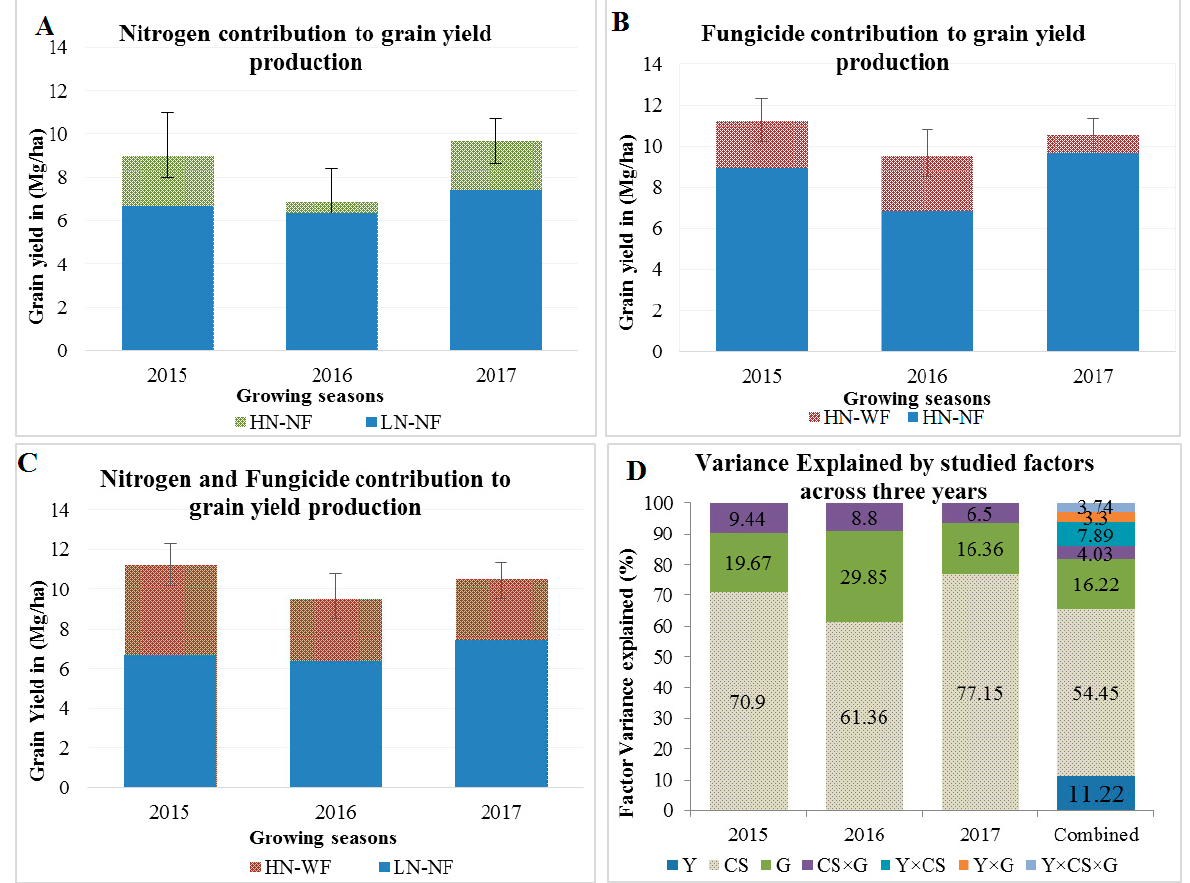
Figure 2. Contribution of nitrogen and fungicide to grain yield (Mg·ha − 1 ) production in 2015, 2016, and 2017 growing seasons and variance components of each factor. ( A ) Blue bars show the grain yield harvested under LN-NF and green/white bar above show grain yield gained from additional fertilization. ( B ) Blue bars are grain yield from HN-NF used as control and the above red/white show gained grain yield owing to fungicide application. ( C ) Blue bars are grain yield harvested under LN-NF (Control) and the above red/green bars show gained grain yield due to combined effect of additional nitrogen fertilization and fungicide application. ( D ) Proportion of the variance components of factors years (Y), cropping systems (CS), and genotypes (G) and their interactions.